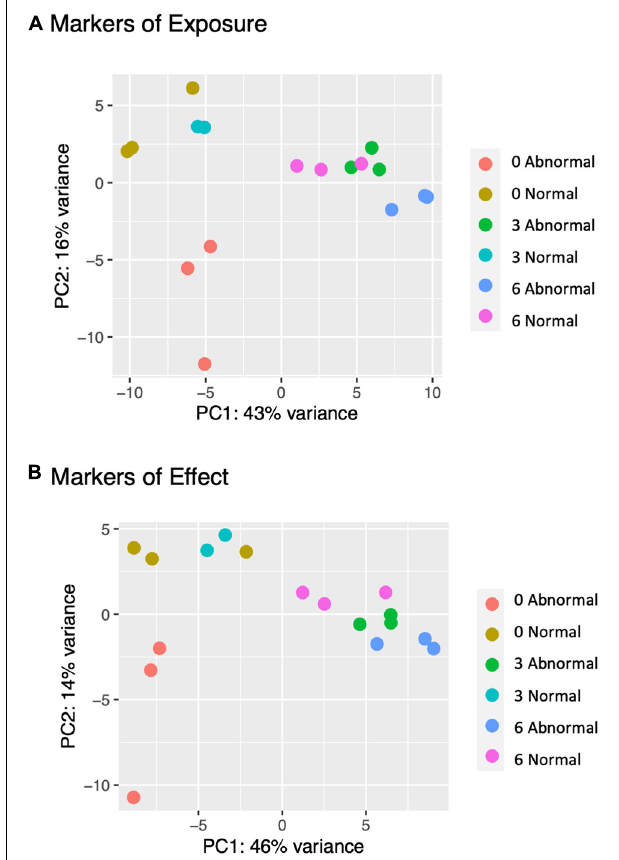
FIGURE 6 | To corroborate trends observed in individual larvae, pooled larval expression data was subset on the markers of exposure and effect generated through single larval analysis. PCA plots of this expression data for markers of exposure (A) and effect (B) confirmed that single larval markers effectively separated pooled larval samples based on morphology and copper